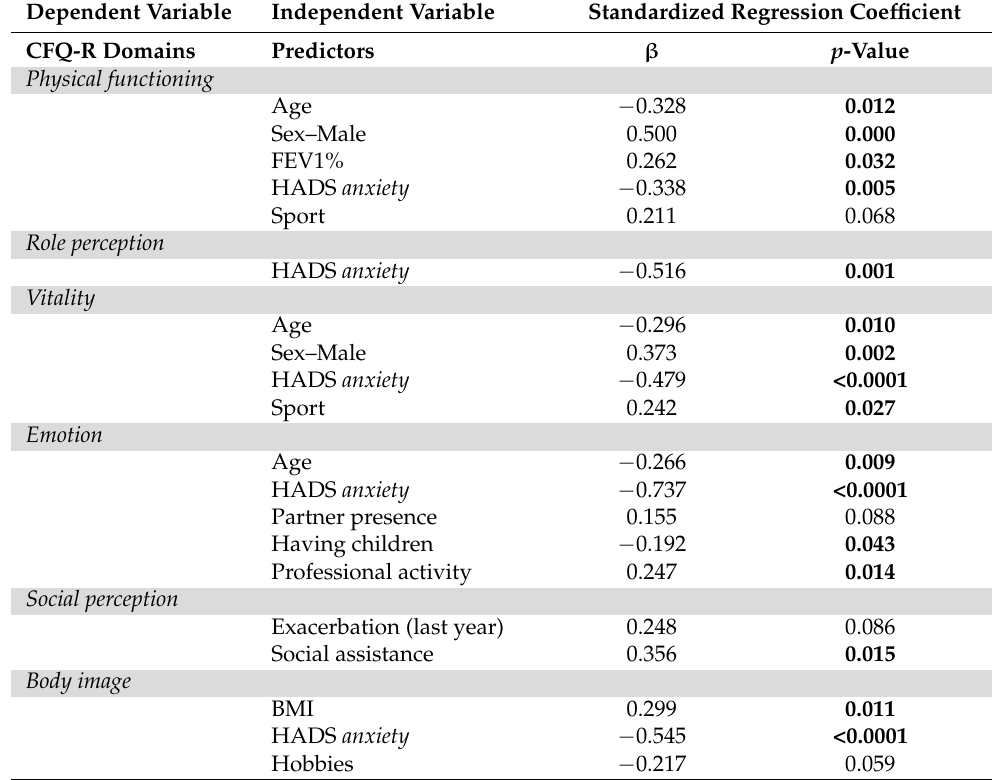
Table 5. Multiple regression analyses for the Cystic Fibrosis Questionnaire-Revised (CFQ-R) in CF adults for HADS